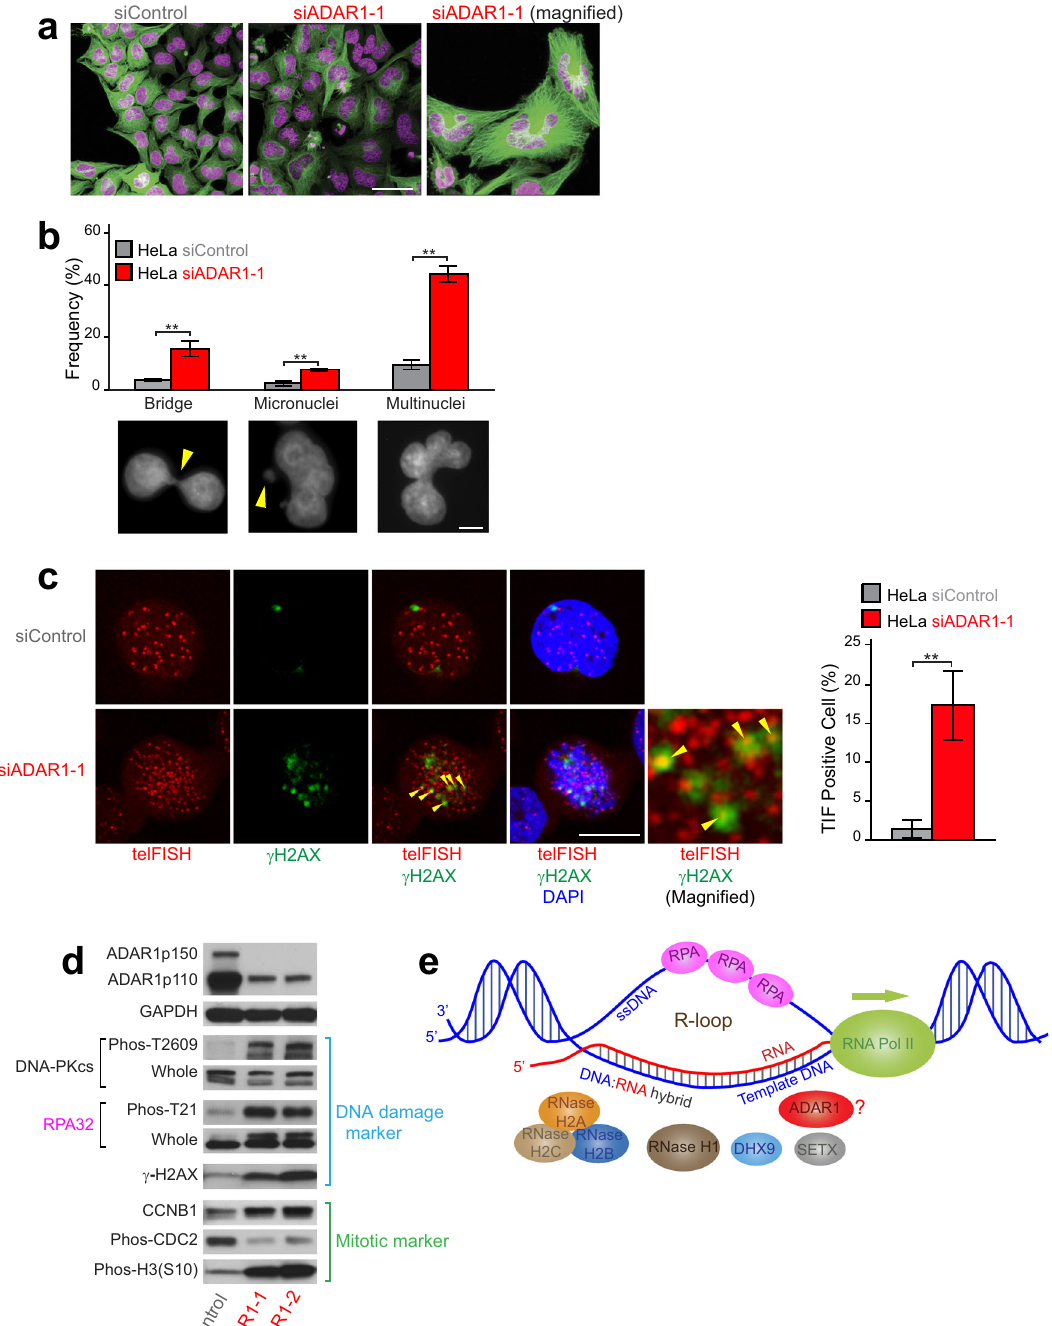
and mitotic arrest 43 – 45 . Dot blot analysis using the S9.6 antibody speci fi c to RNA:DNA hybrids 46 (Fig. 2a) revealed that ADAR1 depletion indeed resulted in signi fi cantly increased the formation of RNA:DNA hybrids (Fig. 2b and Supplementary Fig. 2a). Treatment with Escherichia coli -RNase H, which digests RNA strands of RNA:DNA hybrids, eliminated dot blot signals, con- fi rming speci fi c detection of RNA:DNA hybrids (Fig. 2b). ADAR2 depletion had almost no effect on the formation of RNA:DNA hybrids (Fig. 2c and Supplementary Fig. 2a), indicating that the R-loop regulatory function is speci fi c to ADAR1. RNase H1 26 and H2 28 degrade RNA strands of RNA:DNA hybrids, while DHX9 29 and SETX 30 unwind RNA:DNA